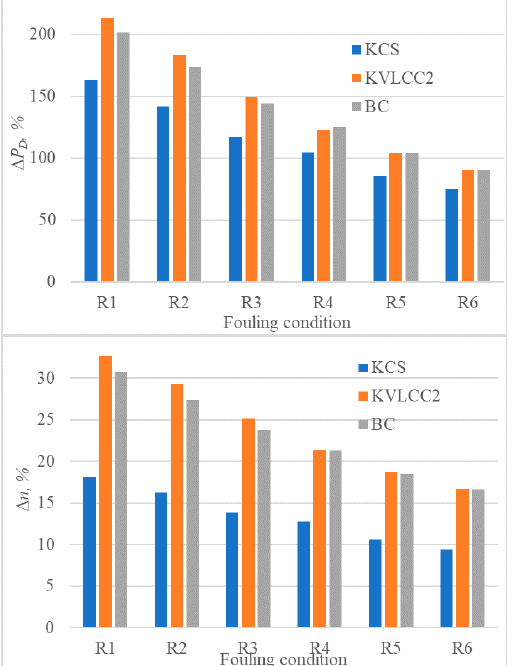
P ( upper ) and n ( lower ) due to the presence of hard Figure 13. The obtained increases in Figure 13. The obtained increases in P D ( upper ) and n ( lower ) due to the presence of hard D fouling.